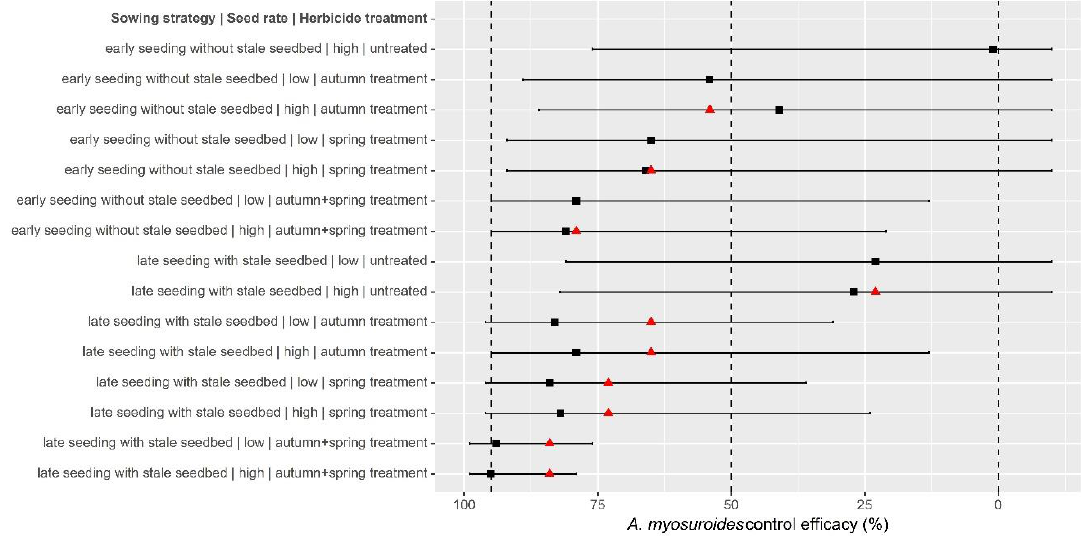
Figure 2. Efficacy of Alopecurus myosuroides control relative to the control treatment, depending on weed management strategy. The control treatment was defined as the combination early sowing, no stale seedbed preparation, no herbicide application, and low winter wheat seed rate. Red triangles represent the calculated expected efficacy for the respective treatment combinations. Black squares represent the observed mean value for the respective treatment combinations. Black bars indicate the 95% confidence interval. For clarity, the x axis is arranged in descending order.